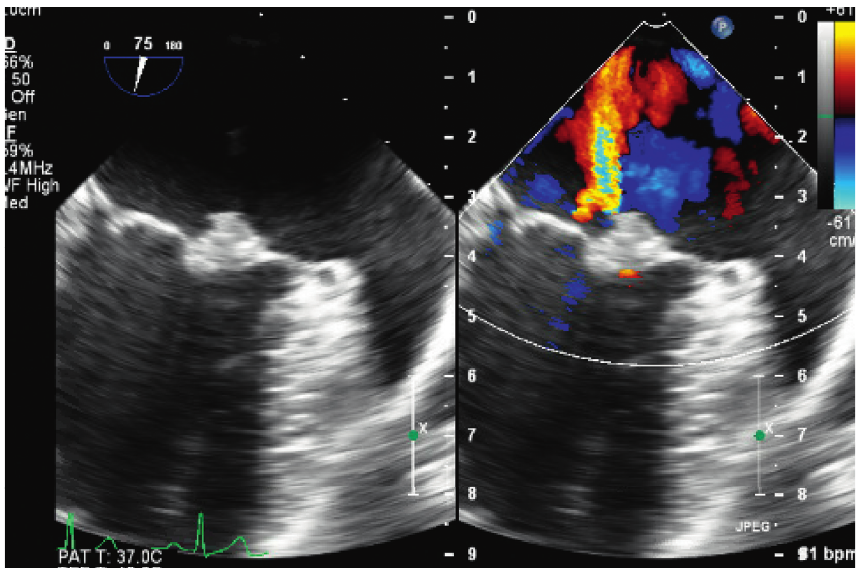
Figure 4: Echo view showing the left atrial mass with color